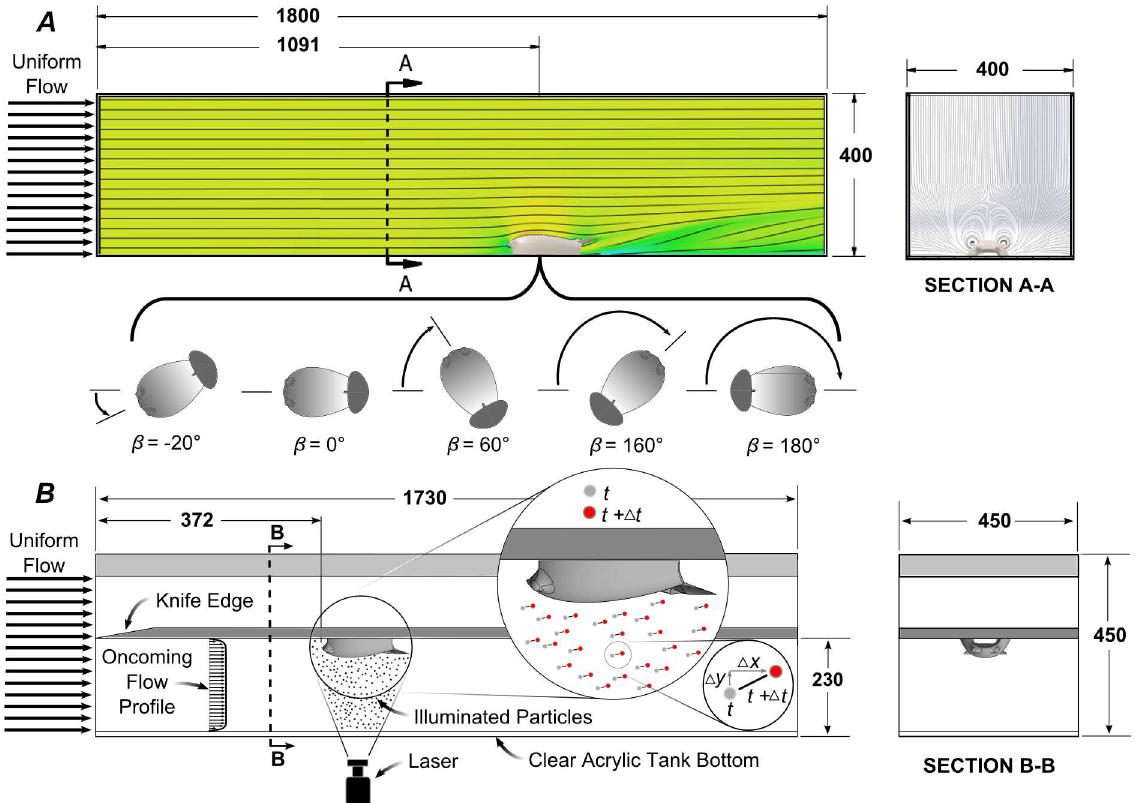
Fig 4. A) Illustration of the computational domain used for the simulations of all models. Streamlines from a representative simulationare also includedin the figure. Representative orientations, β , of the tag in plan view during the examination of off-axis flow are shown below panelA. B) Illustration of the experimental PIV setup used to measurethe flow aroundthe Model A design. The figure inset presents how the illuminatedparticles are used to measurethe velocity of the fluid. The fluid flow in both cases is from left to right, and dimensions are in